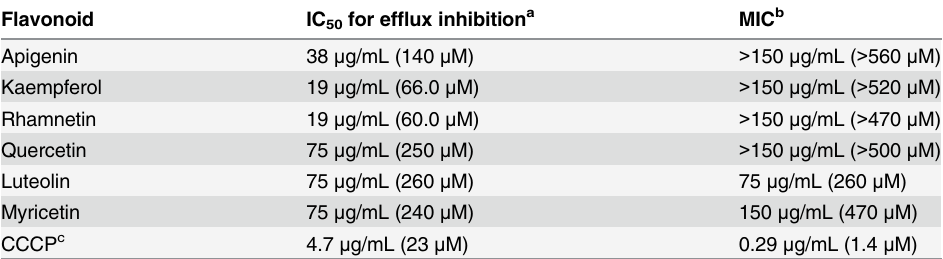
Table 1. Efflux pump inhibitory activity and antimicrobial activity of flavonoids.